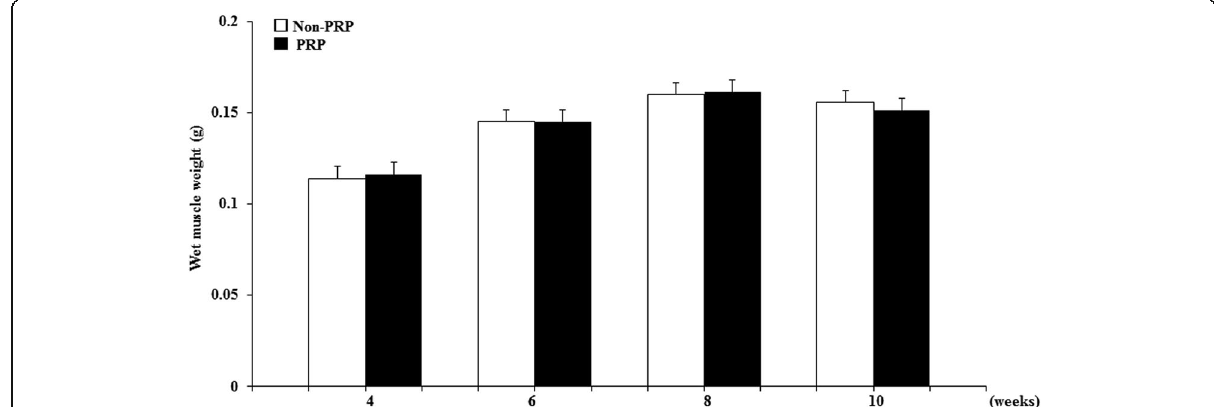
Fig. 3 Time course of changes in wet weight of GC muscles of the non-PRP and PRP groups at 4, 6, 8, and 10 weeks after osteotomy. Data represent mean ± SEM ( n =